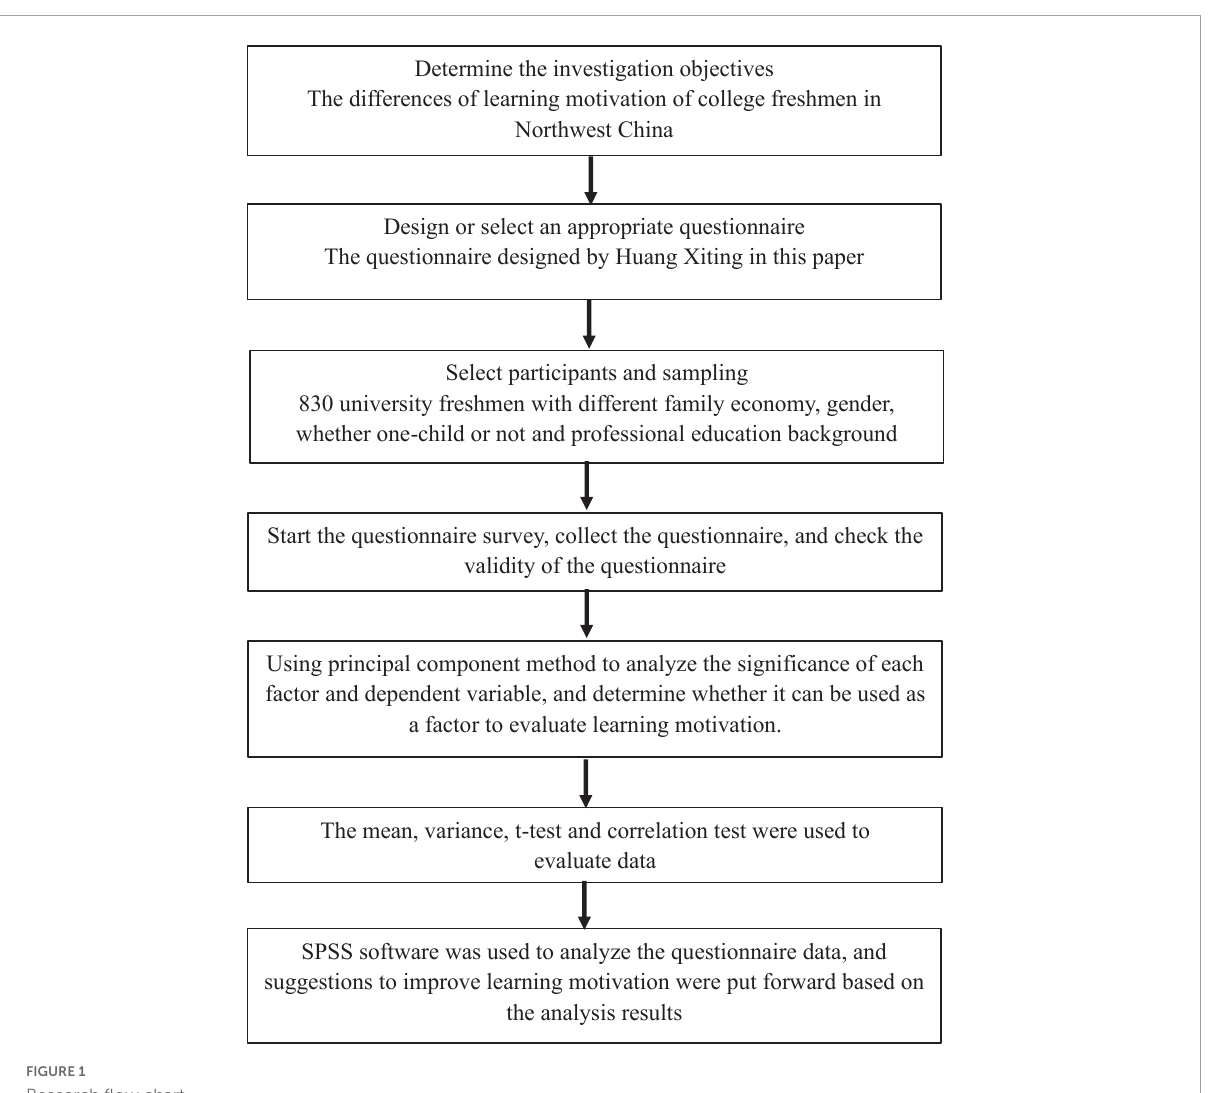
FIGURE1 Research flow